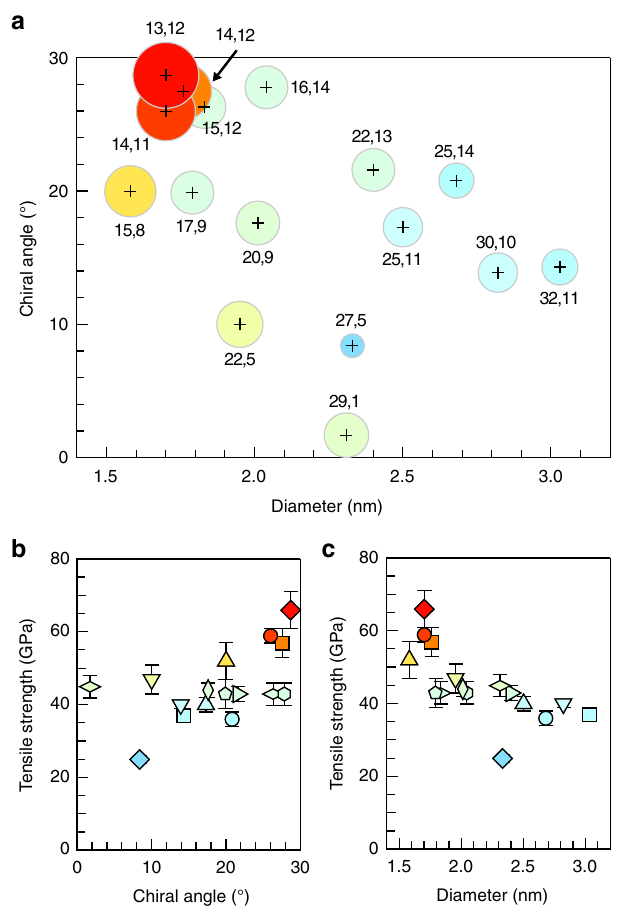
Fig. 3 Chirality dependence of the ultimate tensile strength. a The tensile strengths of the chiral ( n,m ) structures are indicated by the circle diameters. The coordinates of the cross marks correspond to the chiral angle and diameter of each ( n,m ) nanotube. b , c The tensile strengths are plotted as a function of the chiral angle ( b ) and diameter ( c ). The color- symbol combinations of the points correspond to the measured nanotubes. The error bars indicate the 95% con fi dence correspond to the ultimate tensile strengths. If we assume that the nanotube does not slip on the stages, the fracture strain of a nanotube with a strength of ~50 GPa (Supplementary Fig. 2) is estimated as ~5%, suggesting a Young ’ s modulus of ~1 TPa, which is consistent with reported values 29 .